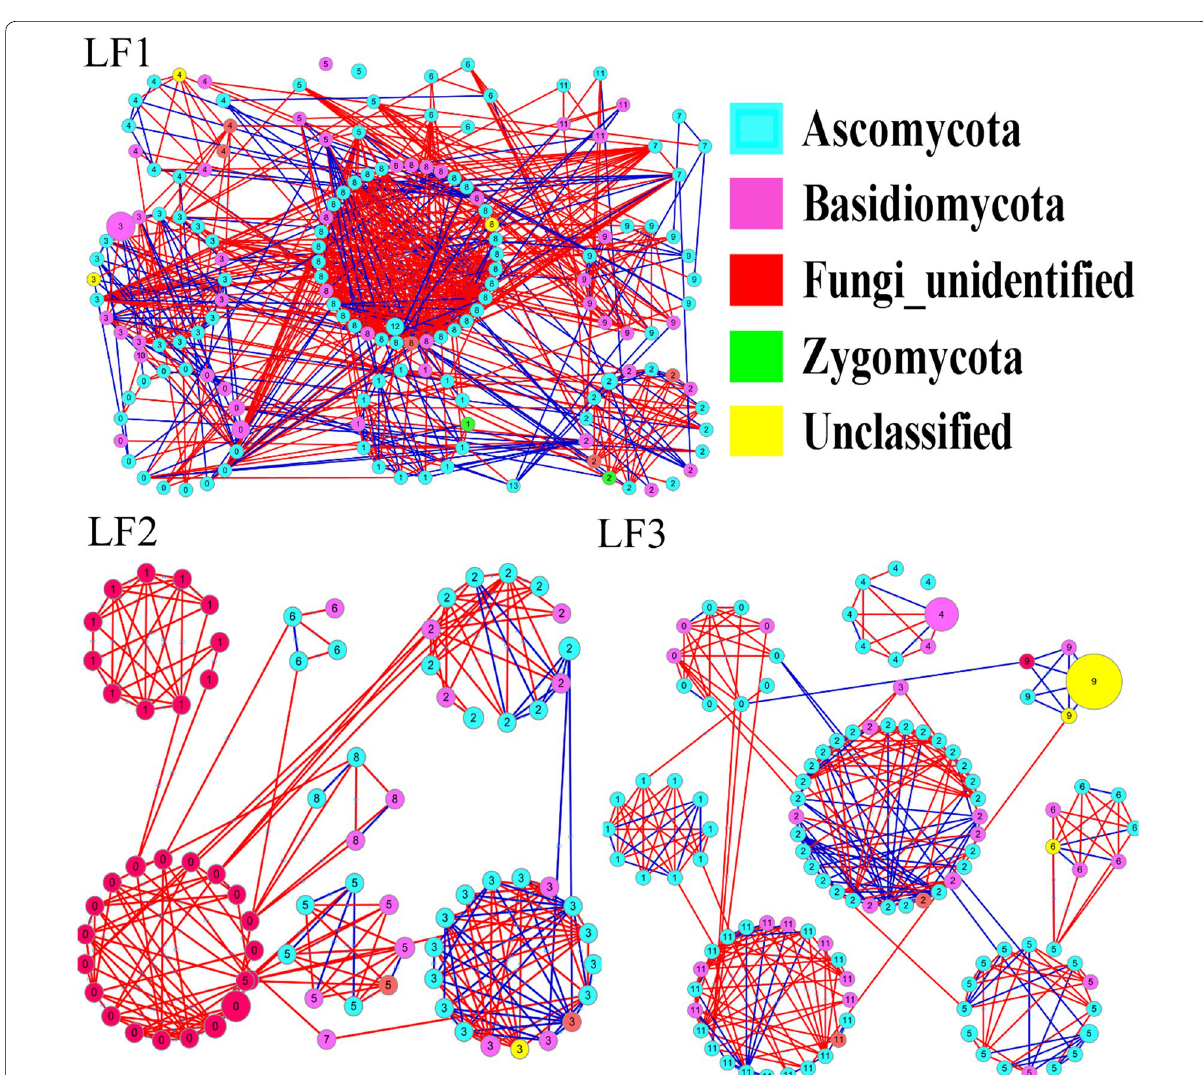
Fig. 4 Phylogenetic molecular ecological networks (pMENs) of fungal communities under different disease severities. Modules with > 5 nodes were obtained for fungal groups (LF1, LF2 and LF3), respectively. The links between two nodes show the correlation (red: positive, blue: negative). The size of circle indicate the relative abundance of the OTU. The number in the center of circle represents the modules to which these OTUs